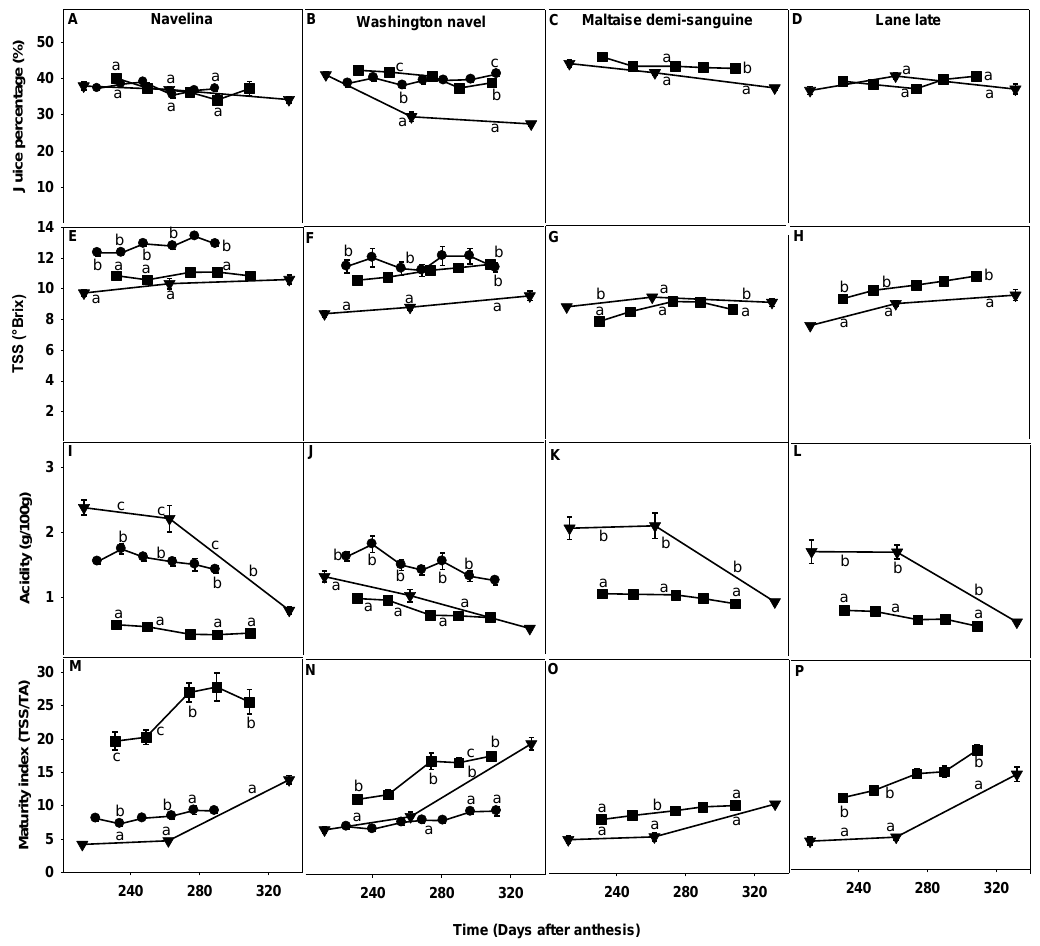
Figure 5. Fruit quality criteria measured in di ff erent orange cultivars during maturation in Corsica ( (cid:72) ) , Spain ( • ) and Tunisia ( (cid:4) ). Juice percentage measured in ( A ) ‘Navelina’, ( B ) ‘Washington navel, ( C ) ‘Maltaise demi-sanguine’ and ( D ) ‘Lane late’. TSS measured in ( E ) ‘Navelina’, ( F ) ‘Washington navel’, ( G ) ‘Maltaise demi-sanguine’ and ( H ) ‘Lane late’. Acidity measured in ( I ) ‘Navelina’, ( J ) ‘Washington navel’, ( K ) ‘Maltaise demi-sanguine’ and ( L ) ‘Lane late’. The maturity index calculated for ( M ) ‘Navelina’, ( N ) ‘Washington navel’, ( O ) ‘Maltaise demi-sanguine’, ( P ) ‘Lane late’. Values are means ± SE ( n = 12). Anthesis occurred in the first, second and fourth week of April, 2012 in Tunisia, Spain and Corsica, respectively. Day 150 after anthesis thus corresponds to 09 / 26 / 2012 in Corsica, 09 / 12 / 2012 in Spain, and 09 / 07 / 2012 in Tunisia. The di ff erent letters indicate statistically significant di ff erences ( p ≤ 0.05).